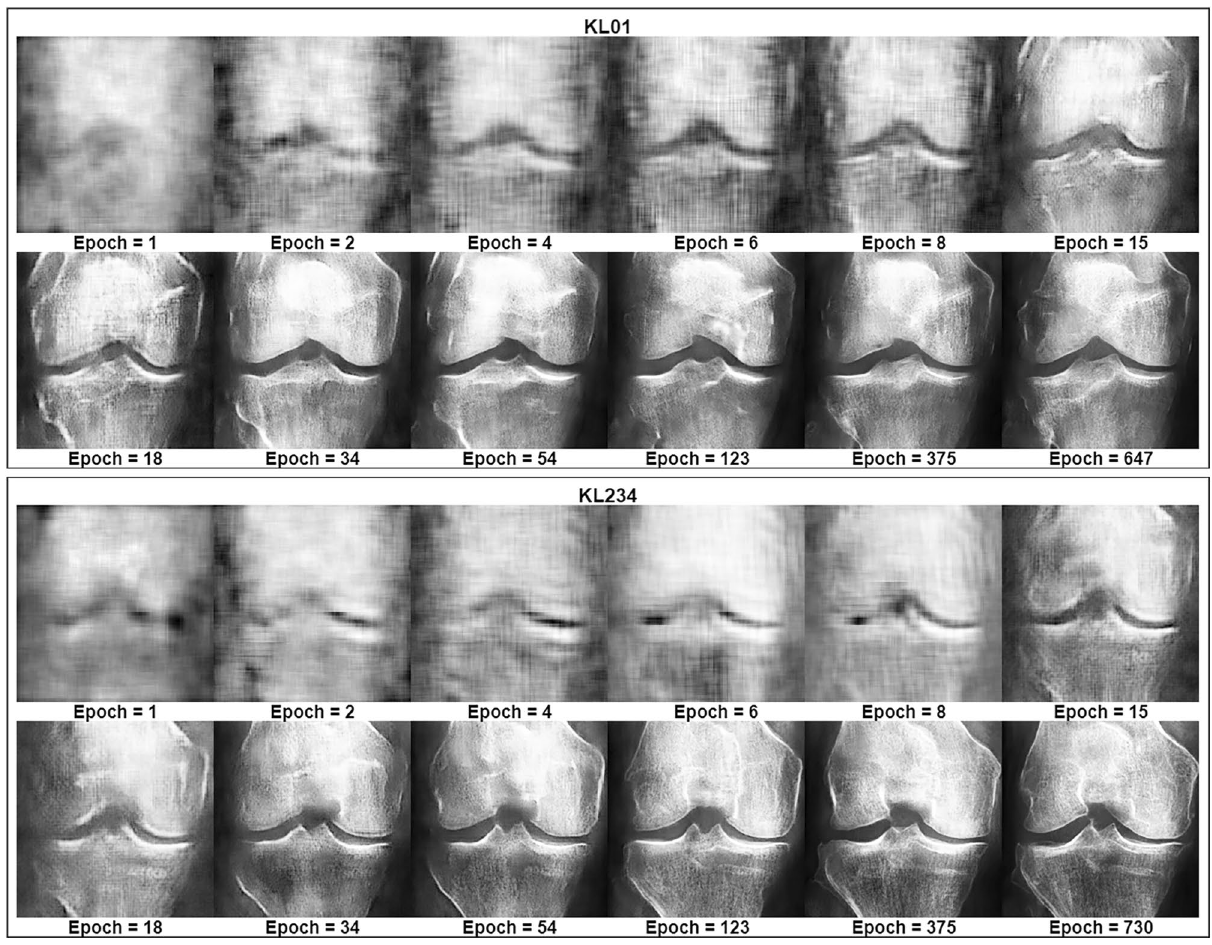
Figure 1. Training progress visualization with fixed latent space representation. Training improvements occurring over time are depicted for the KL01 and KL234 WGANs. All images in this figure are